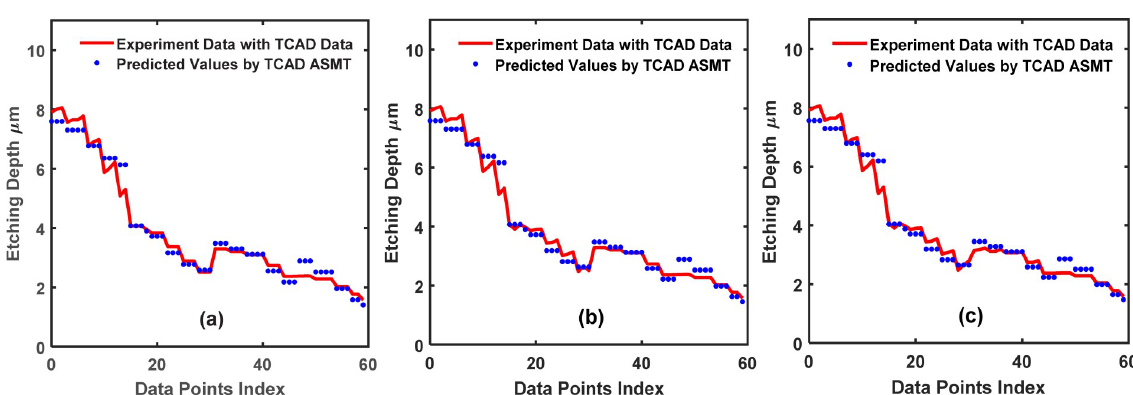
Fig 11. Training set fitting for the 2-input dataset using the TCAD-labeled ASMT algorithm. The partition values, 15, 30, and 45, are shown in (a), (b) and (c), respectively.